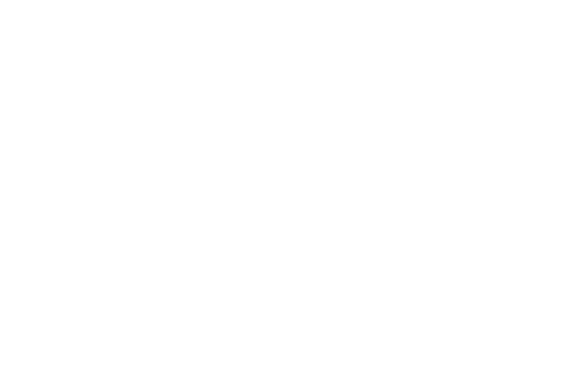
Figure 4. Geometrical parameters of a single cutter defined as back-rake ( θ ) and side-rake ( φ )